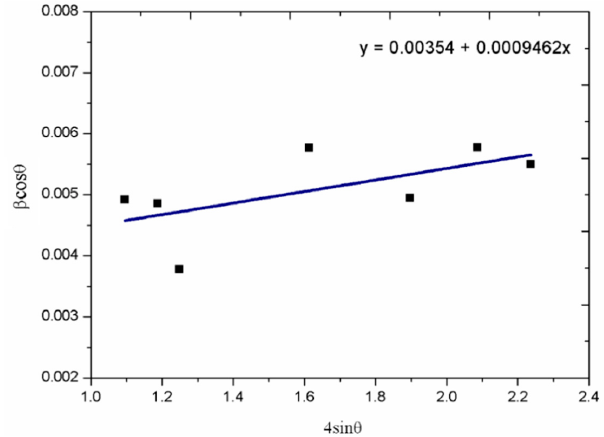
Figure 3. Williamson-Hall (W-H) analysis integrated with Uniform Deformation Model (UDM) model of S1.